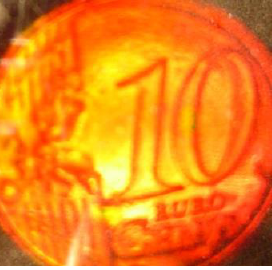
Figure 3. Denisyuk reflection hologram recorded in DA-based photopolymer, illuminated in white light.